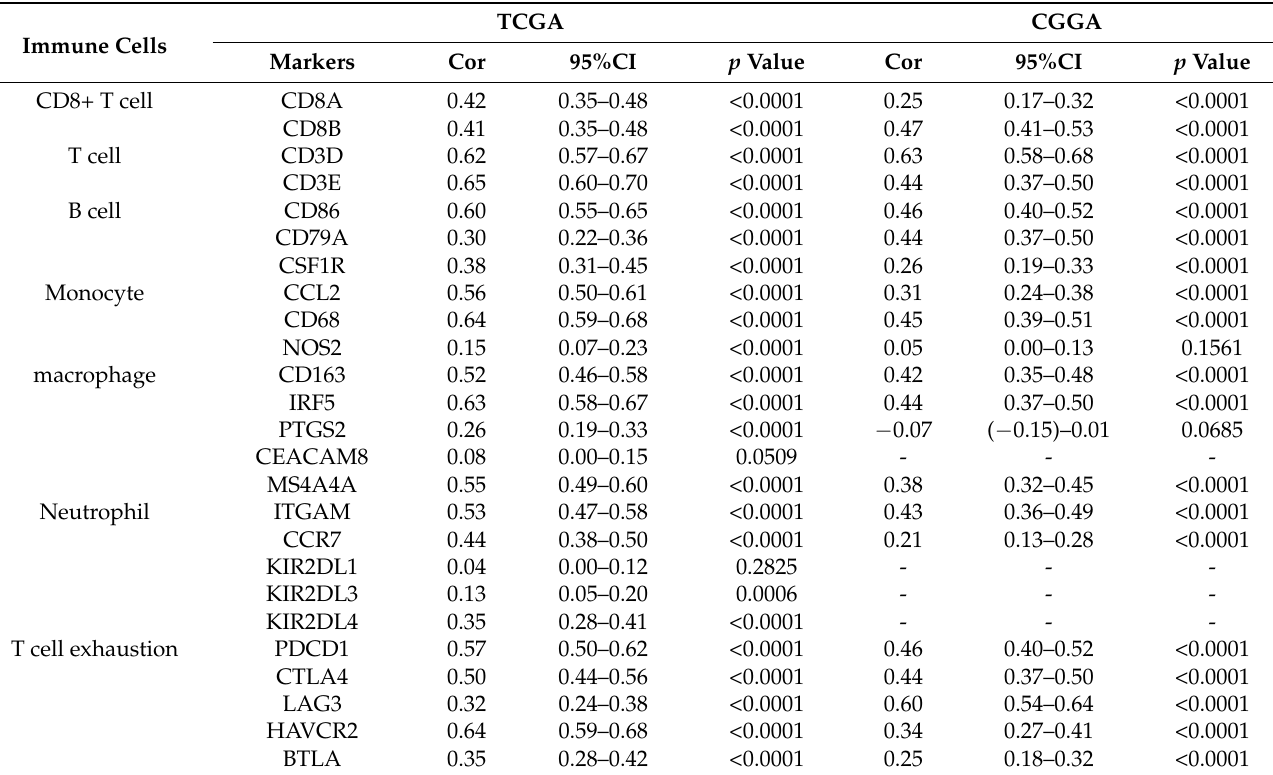
Table 4. Correlation between GSDMD expression and markers of immune